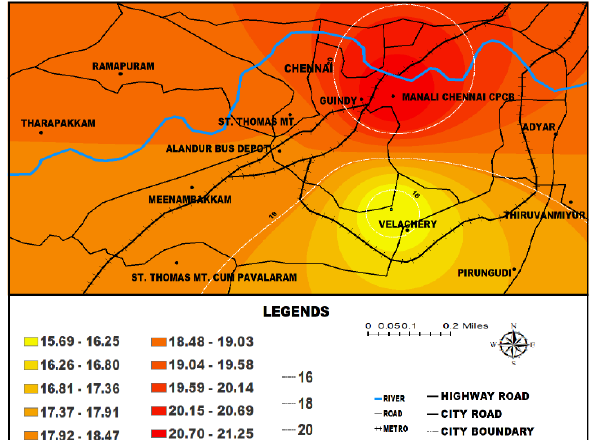
Figure 11. Air quality map of Chennai January monthly average based on NOx (µg/m 3 ).